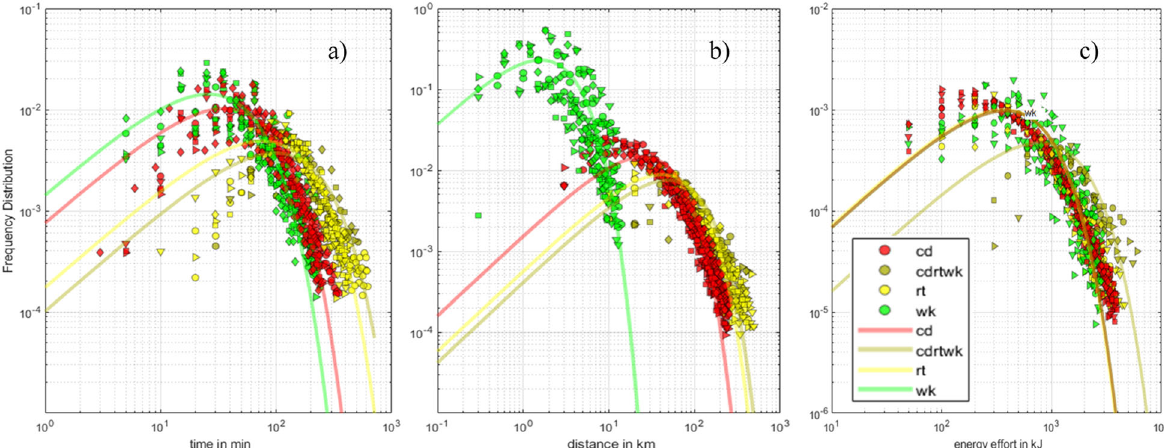
Fig. 3 Travel distribution functions. Data and distribution functions of daily travel time a , distance b and energy c in a double logarithmic representation. Note that the x -axis can now depict all